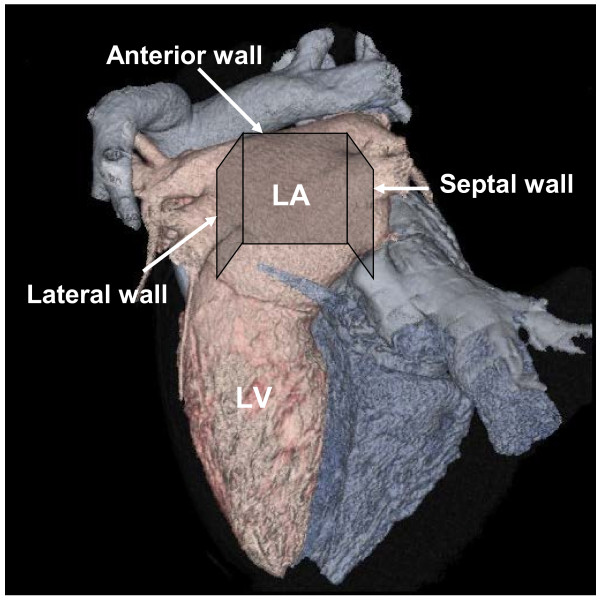
Measurement site of left atrium. Schematic image of the analyzed site (square). Lateral, anterior and septal walls of the left atrium were analyzed. LA: left atrium. LV: left ventricle.